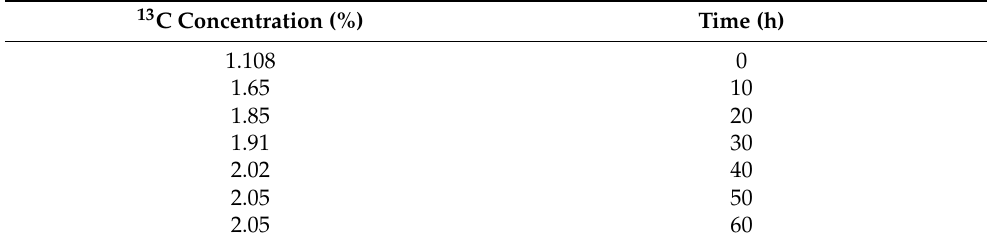
Table 1. The separation process experimental data— 13 C